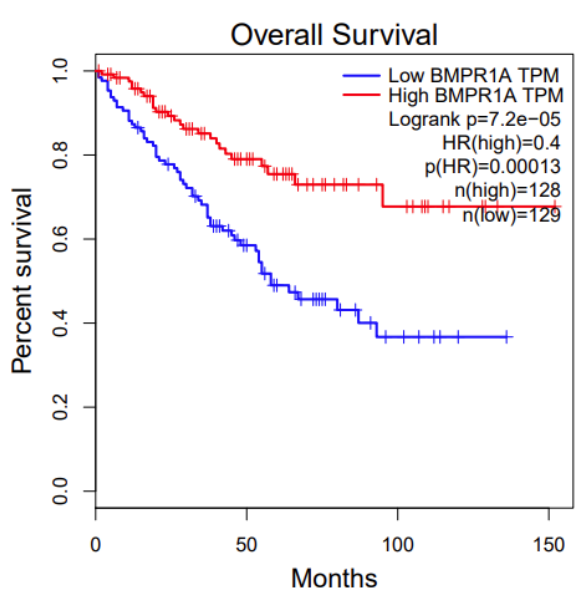
Figure 3. Survival analysis of BMPR1A in TCGA (The Cancer Genome Atlas) KIRC (kidney renal clear cell carcinoma).